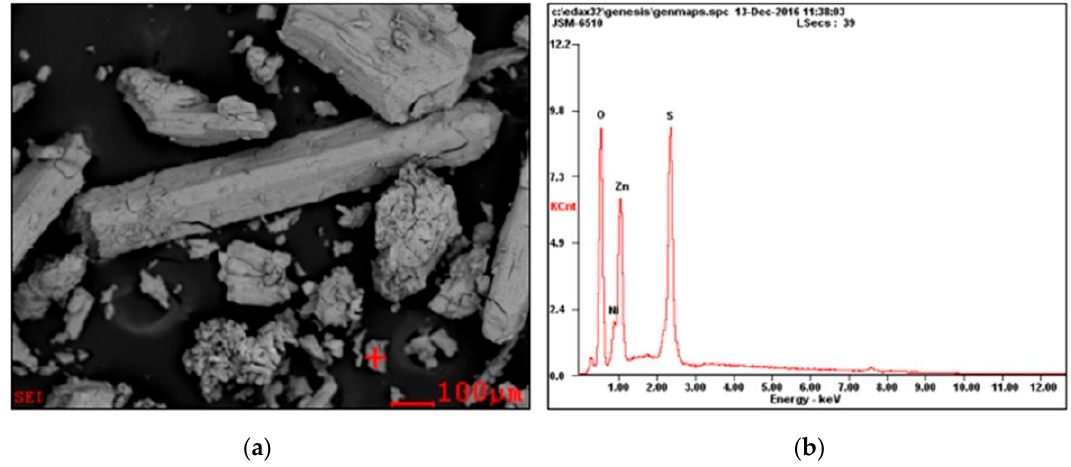
Figure 6. Scanning electron microscope (SEM) and energy-dispersive X-ray spectroscopy (EDS) diagrams of ZnSO 4 crystal products. ( a ) SEM; ( b ) EDS.